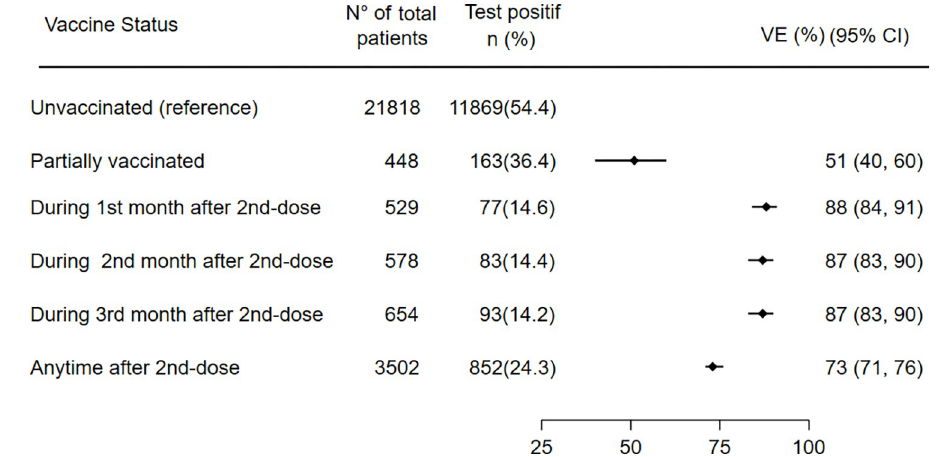
Fig 1. Estimates Vaccine effectiveness of inactivated vaccine BBIBP-CorV against COVID-19-associated severe or critical hospitalization according to vaccination status and by time since